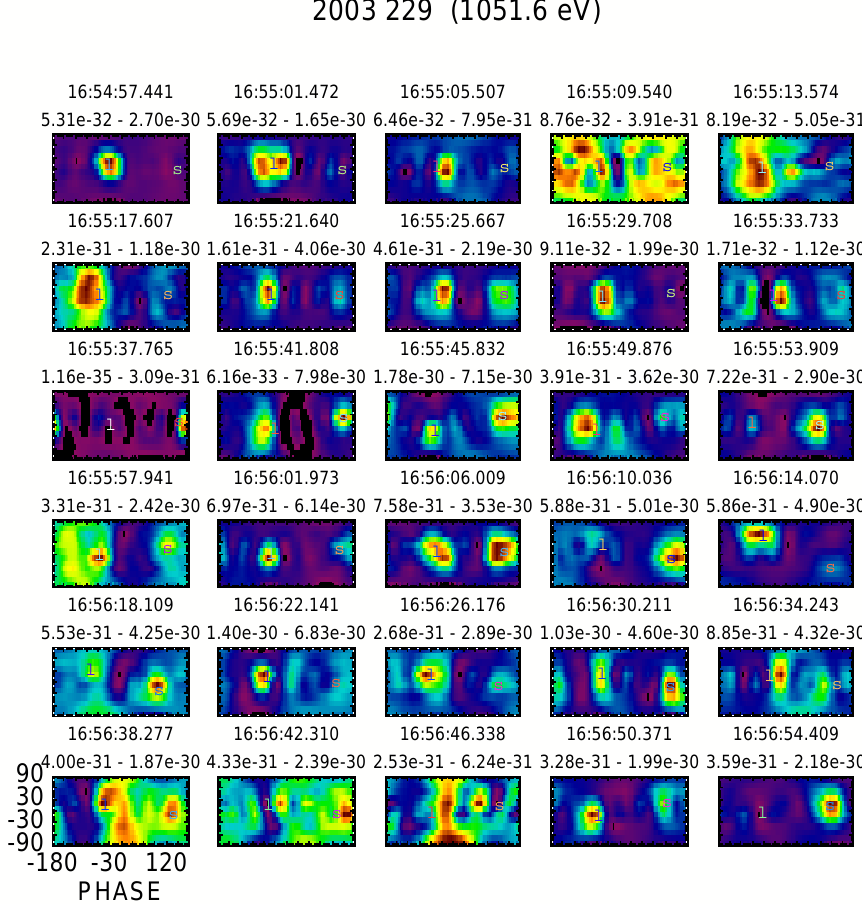
Fig. 5. A set of phi/theta of the eVDF in units of s 3 cm − 6 during a period of enhanced vorticity on day 229 of 2003. The plots show cuts through successive eVDFs at a fixed energy step (1051eV). The start accumulation time of each eVDF and the applied scaling range is shown above each plot. The figure illustrates the rapid switching between bi-directional and single